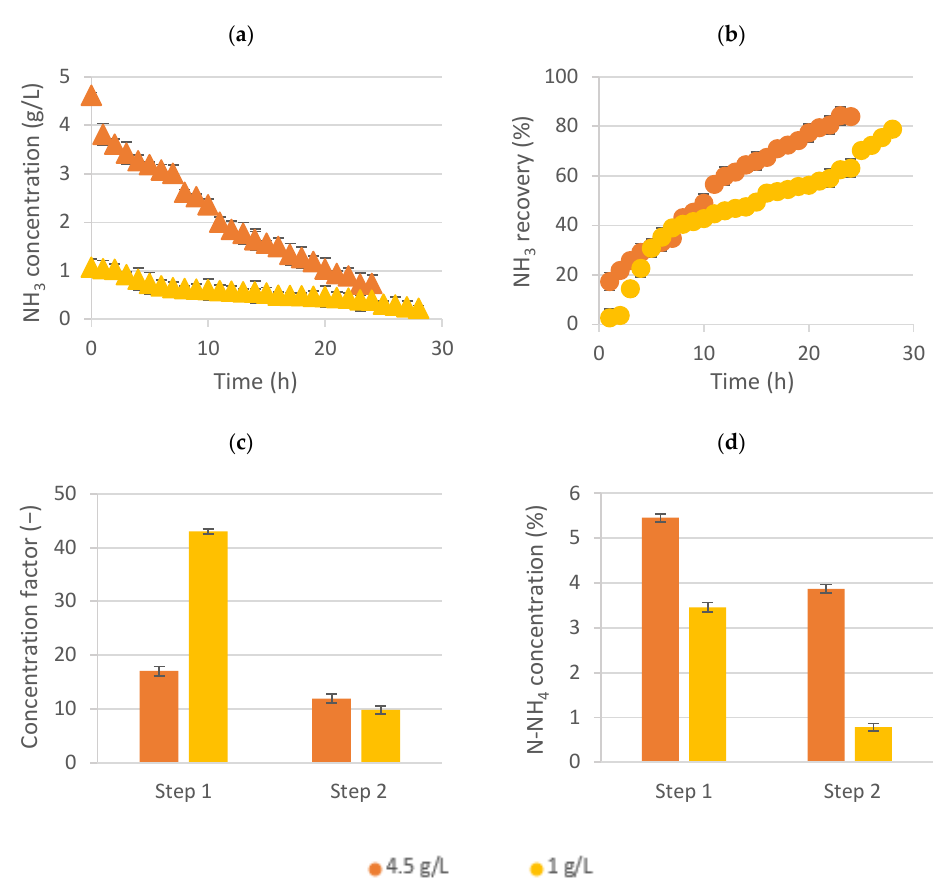
Figure 3. Comparison between working with the sidestream (high NH 3 concentration) and main- stream wastewater (low NH 3 concentration): ( a ) ammonia concentration evolution in the feed tank, ( b ) ammonia recovery, ( c ) concentration factor and ( d ) %N-NH 4 concentration in the liquid fertilizer. High ammonia concentration is indicated by the color orange, while the color yellow implies working at low ammonia